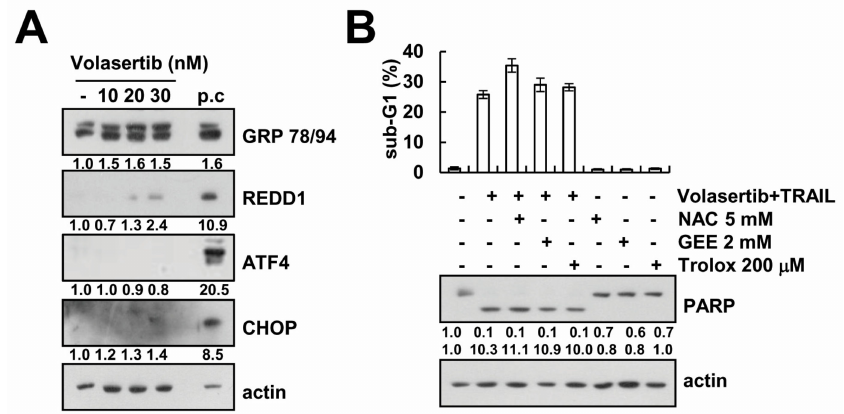
Figure 5. TRAIL sensitization by volasertib is independent of ER stress and ROS signaling pathway. ( A ) Caki cells were treated with the indicated concentrations of volasertib or 2 µ M brefeldin A (P.C; positive control) for 6 h. The protein expression levels of Grp78/94, REDD1, ATF4, CHOP, and actin were determined via Western blotting. ( B ) Caki cells were pretreated with 5 mM NAC, 2 mM GEE, and 200 µ M trolox for 30 min, and then supplemented with 50 ng/mL TRAIL plus 30 nM volasertib for 24 h. The sub-G1 fraction was measured via flow cytometry. The expression of PARP and actin were determined via Western blotting. The values in graph ( B ) represent the mean ± SD from three independent samples.